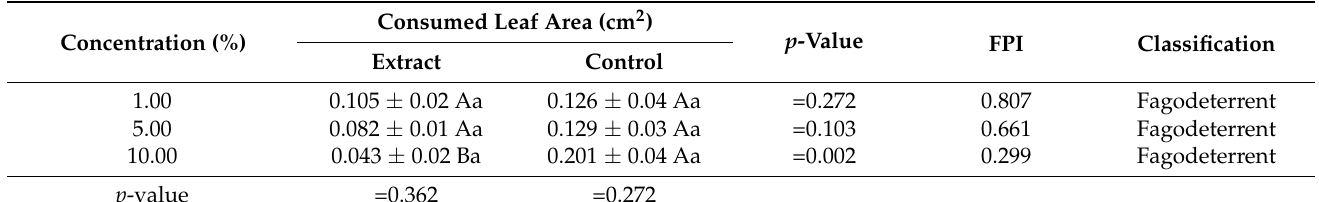
Table 4. Feeding preference index (FPI) of Plutella xylostella according to consumed leaf area of discs treated with distilled water (control) or botanical extracts of M. albicans .